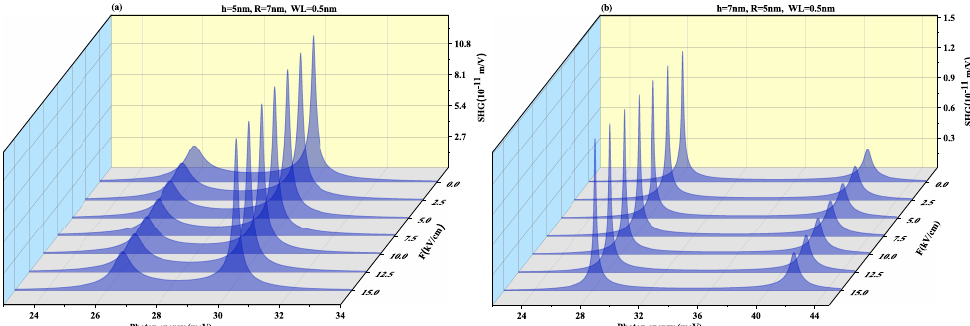
Figure 17. Second harmonic generation as a function of the photon energy for ( a ) oblate height h = 5 nm with radius R = 7 nm at WL thickness 0.5 nm ( b ) prolate QD with R =5 nm, h = 7 nm with WL thickness = 0.5 nm for different perpendicular electric field strengths from F = 0 to 15 kV/cm.